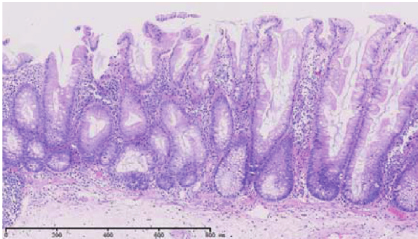
Figure 2: Serrated hyperplasia of the crypts and basal dilation of some crypts, consistent with SSA.